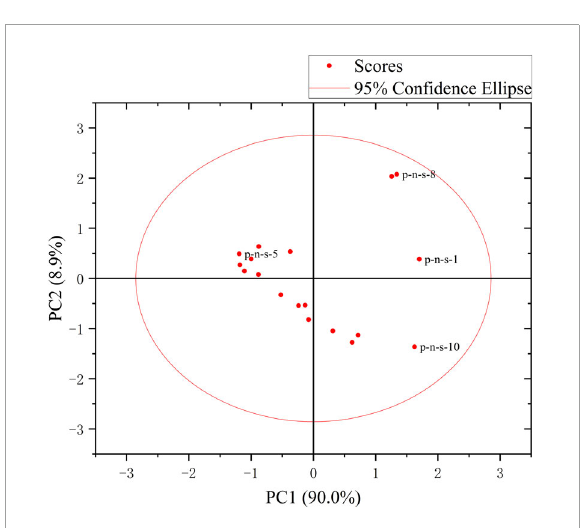
FIGURE9 Two-dimensional scatter diagram of PC1 and